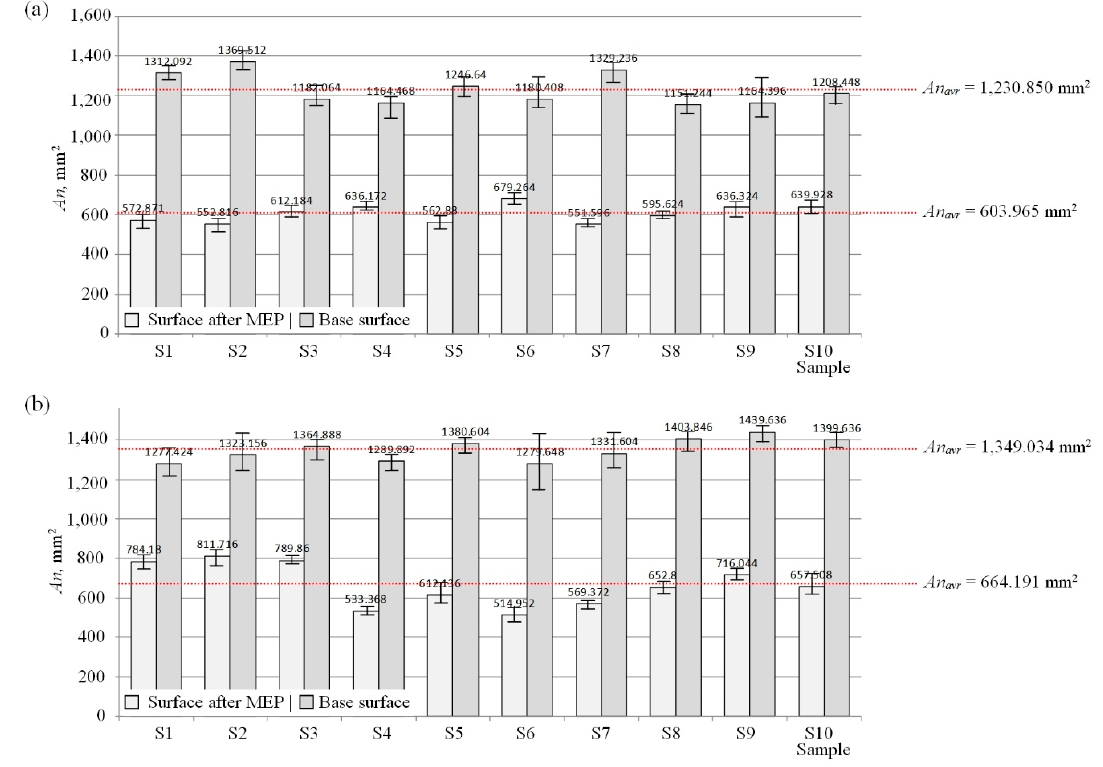
Figure 5. Average values of area (of the bright regions of scattered light image) obtained for surface after the MEP process and base surface for samples ( a ) MEP-800; ( b ) MEP-50.